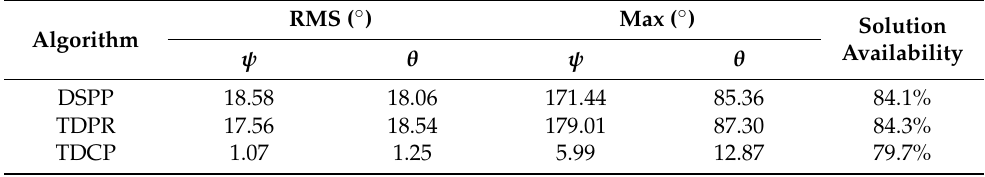
Table 3. RMS, absolute maximum error, and solution availability of the heading and pitch estimates from the DSPP, TDPR, and TDCP